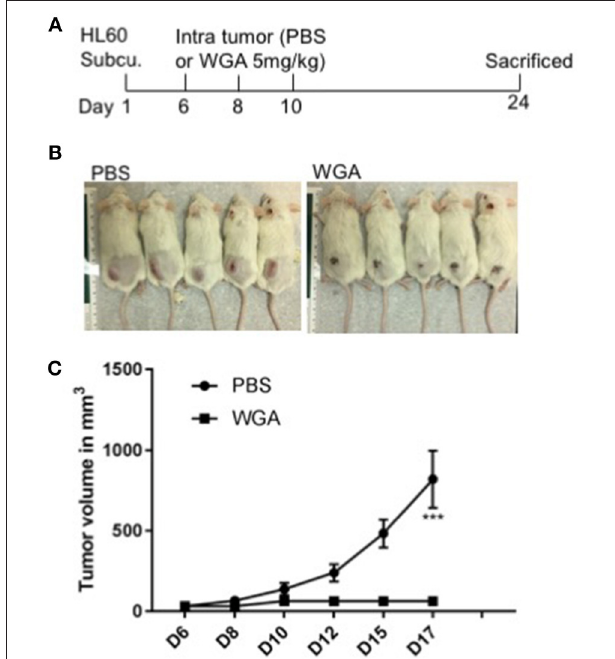
FIGURE 7 | WGA induced AML cell killing in xenograft mouse model. (A) Treatment scheme- HL-60 cells injected at day 1 and at day 6, 8 and 10 WGA 5mg/kg injected intratumorally and mice were sacrificed at day 24. (B) Pictures of mice treated with PBS or WGA (C) Graph showing tumor volume (mm 3 ) of PBS and WGA injected mice. *** p <